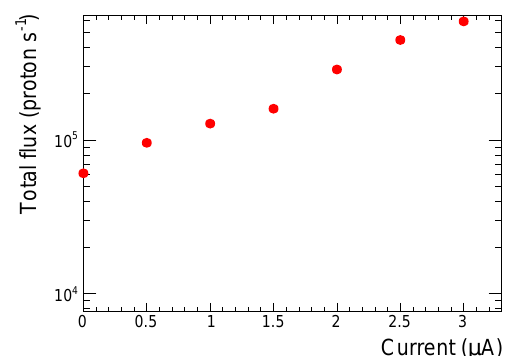
Figure 8. Total proton flux as a function of the ion source discharge current. The zero current value correspods to the ion source switched off. Figure taken from [12].